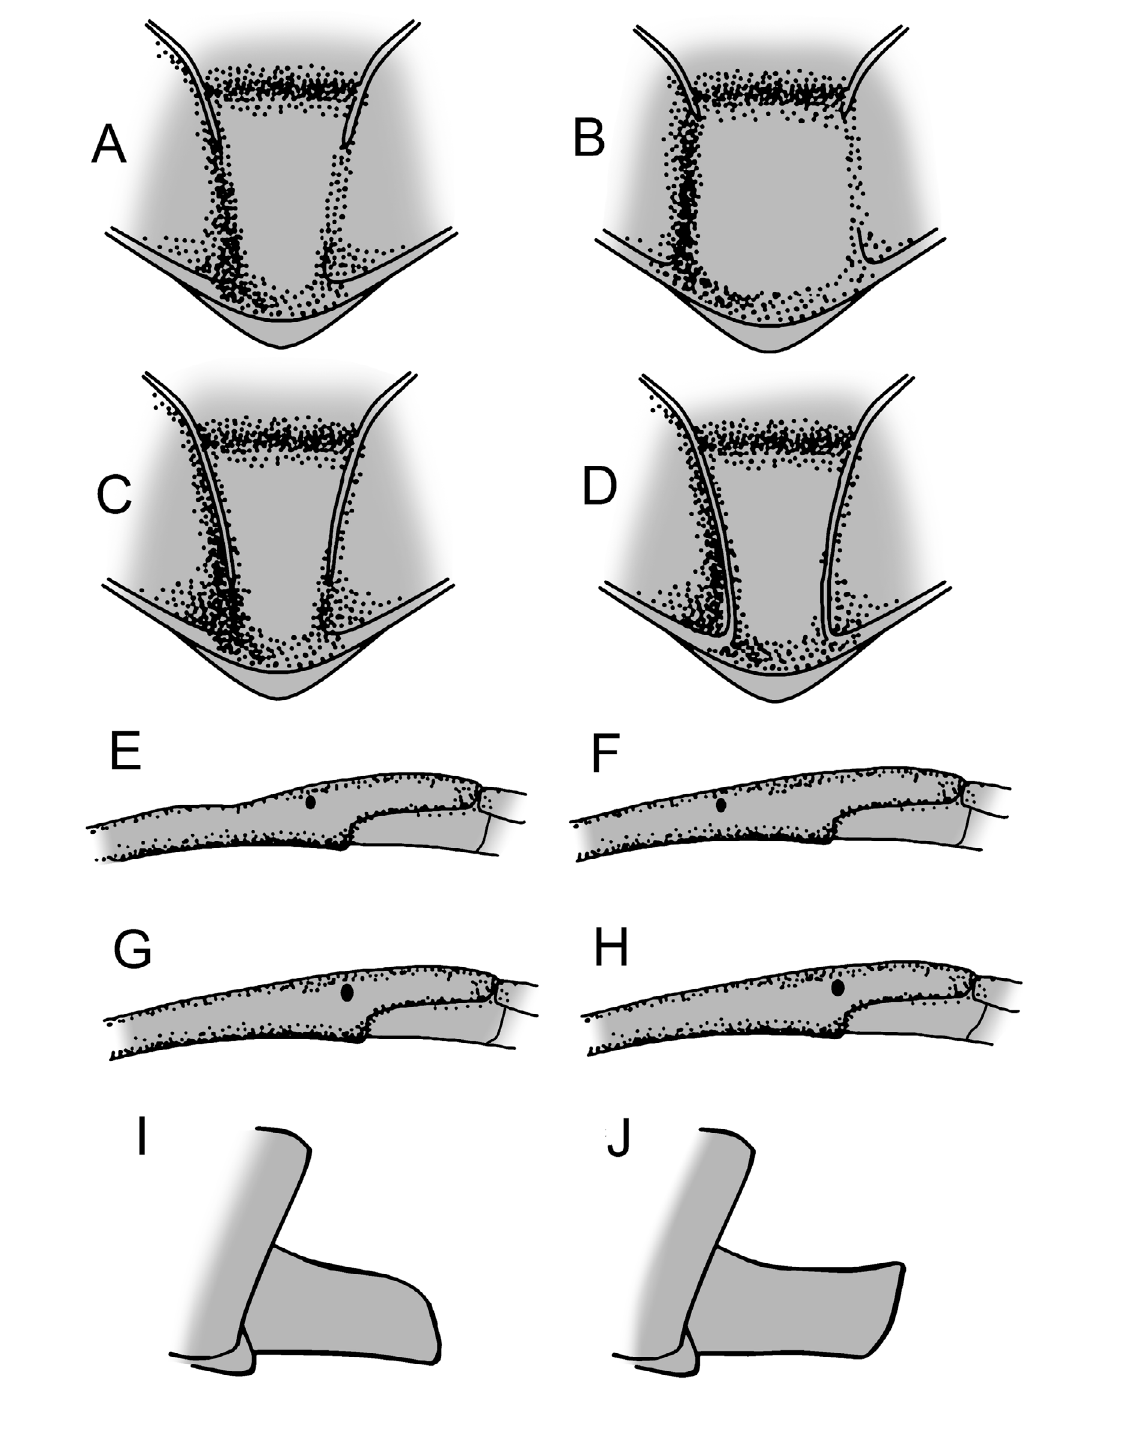
Fig. 6. A–D . Scutellum, dorsal view. A . Ophion luteus (Linnaeus, 1758) . B . O. areolaris Brauns, 1889. C . O. inclinans Johansson sp. nov., holotype, ♀ (NHRS-HEVA000008667). D . O. dispar Brauns, 1895. E–H . First tergite, lateral view. E . O. inclinans Johansson sp. nov., holotype, ♀ (NHRS-HEVA000008667). F . O. dispar . G . O. artemisiae Boie, 1855. H . O. luteus . I–J . Shape of male parameres, lateral view. I . Ophion sp. cf. pseudocostatus Meyer, 1935. J . O. artemisiae